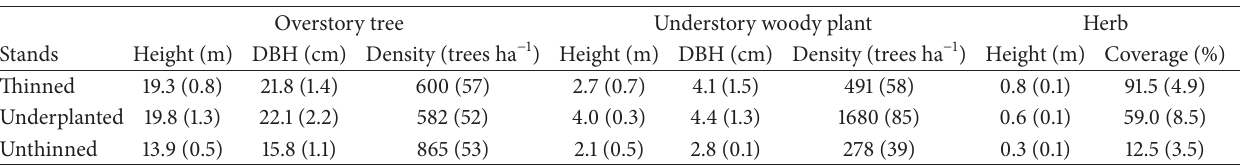
Table 1: Characteristics of vegetation in thinned, underplanted, and unthinned stands (standard deviation in brackets); DBH is diameter at breast